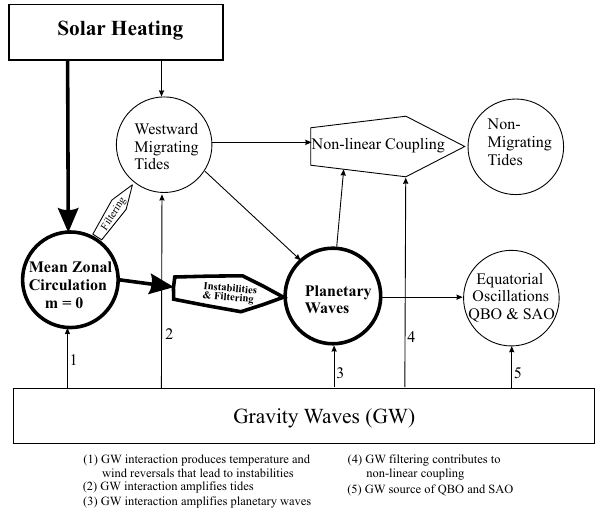
Fig. 3. Schematic illustrating the dynamical features and processes involved in generating the PWs. In the mean zonal circulation (m=0), which includes the jets near the tropopause, the PWs are generated by instabilities, and they are modified by filtering. The nonmigrating tides in the NSM are produced by nonlinear coupling between migrating tides and PWs. As enumerated in the figure, GW interactions cause in the mesosphere reversals in the zonal winds and temperature variations. The GWs amplify the PWs (and tides), and they generate the